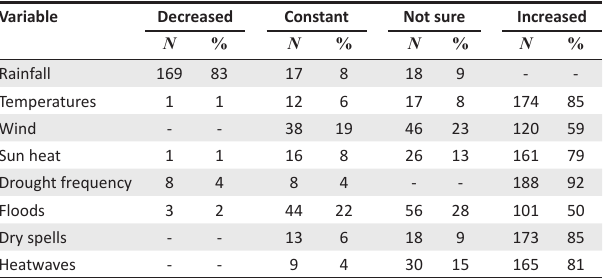
TABLE 3: Respondents’ perceptions of rainfall and climate